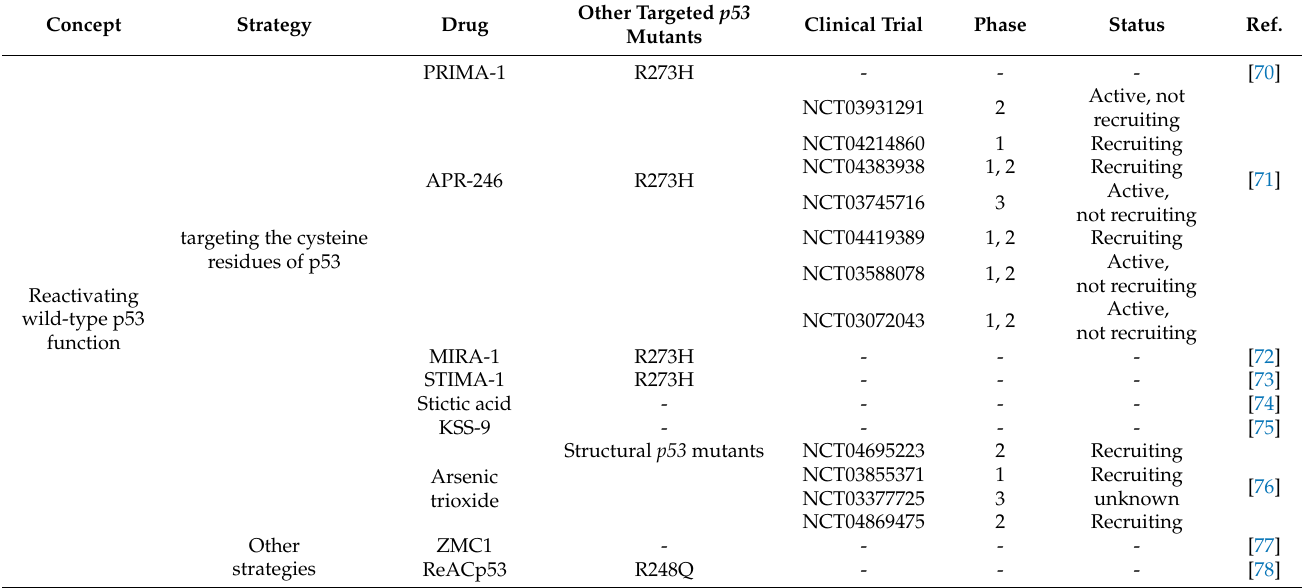
Table 7. Summary of drugs and strategies targeting p53-R175H for cancer